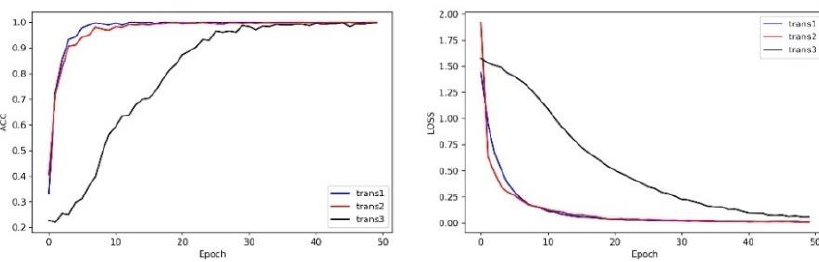
Figure 11. Comparison of three transfer methods under 0.125 data size.